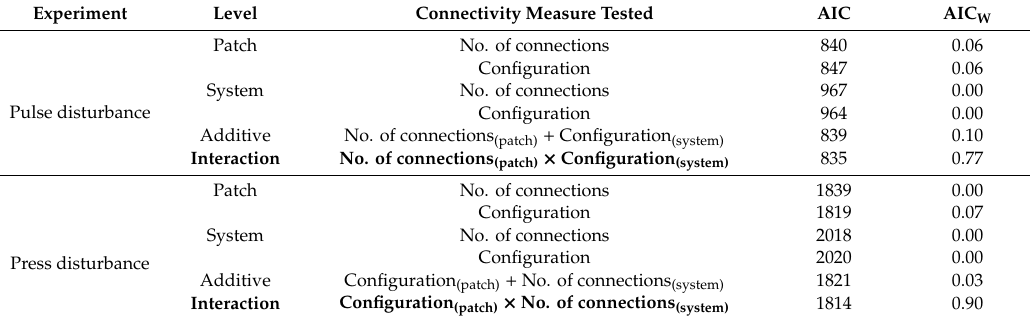
increased herbivory ( p < 0.05 for all models). Best models for herbivory in response to pulse and press disturbances are in bold, determined using the di ff erence in Akaike Information Criterion (AIC) values from generalised linear mixed models; ∆ i. Akaike weights (AIC W ) are used to show the probability that the model is better than those being compared. No. of connections = number of connections between undisturbed and disturbed patches at the system level or number of direct connections to individual